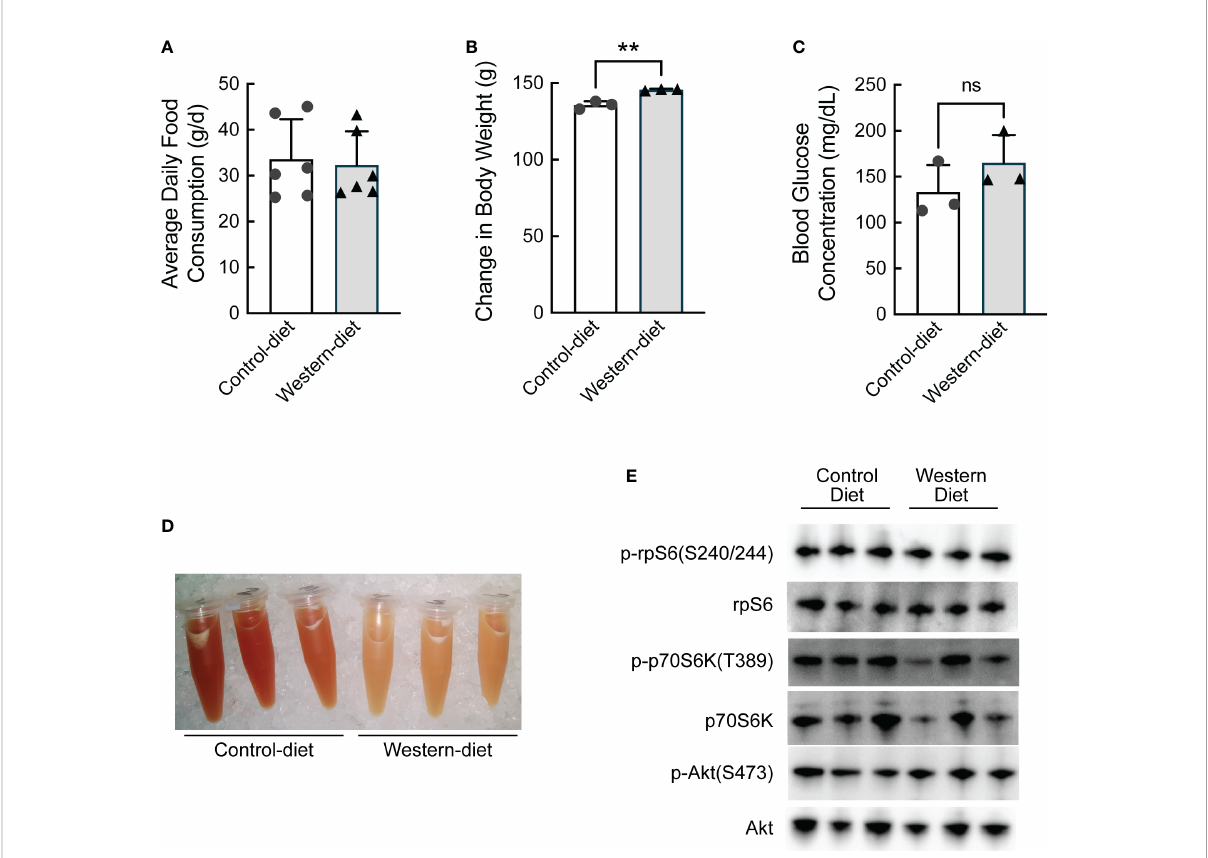
FIGURE 1 Characterization of the effect of short-term (2 weeks) consumption of a Western diet. (A) Average daily food consumption over six 3-d periods, (B) change in body weight, (C) fasting blood glucose concentration, (D) image of liver homogenates, and (E) Western blot analysis of liver homogenates. N=3 rats/condition; **p<0.005 vs control diet. ns, not signi fi